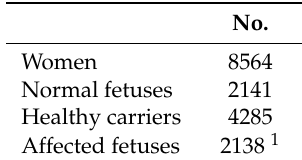
Table 3. Fetal diagnosis of β -thalassemia